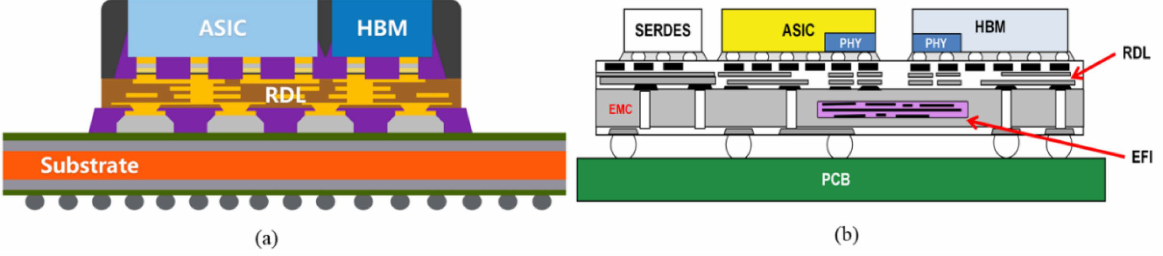
Figure 10. ( a ) FOCoS Technology (reprinted from Ref. [53], Copyright 2019, with permission from IEEE); ( b ) wafer-level packaging using embedded fine-pitch interconnect chips (reprinted from Ref. [54], Copyright 2018, with permission from